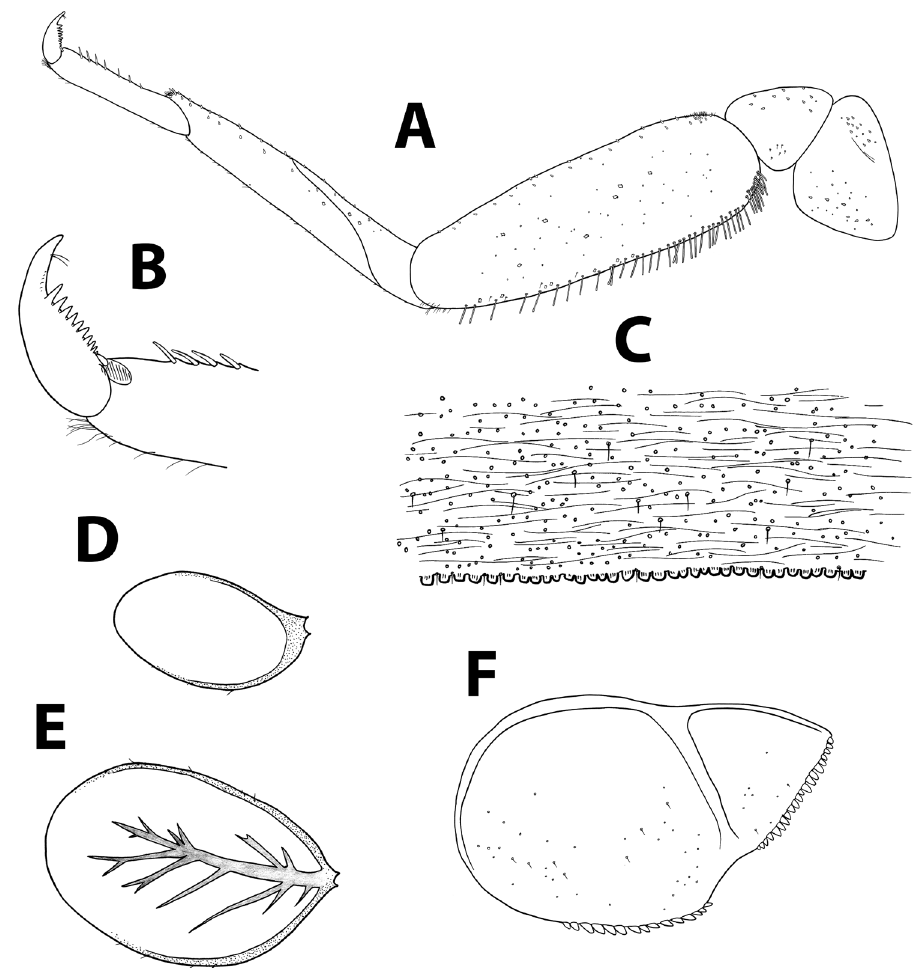
Figure 8. Baetis golanensis sp. n., nymph. A foreleg B tarsal claw C abdominal tergum V, surface and distal margin D gill I E gill IV F paraproct